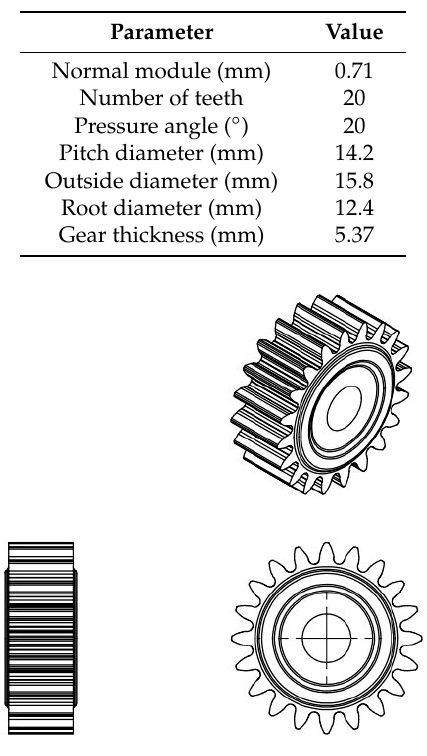
Figure 1. Geometry of the powder metallurgy (P / M) small-module spur gears. Image taken from [26]. Table 1. Main geometrical data for the investigated small-module spur gears. Parameter